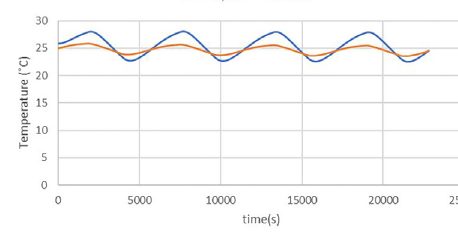
Fig. 8: Equipment temperature change on panel one